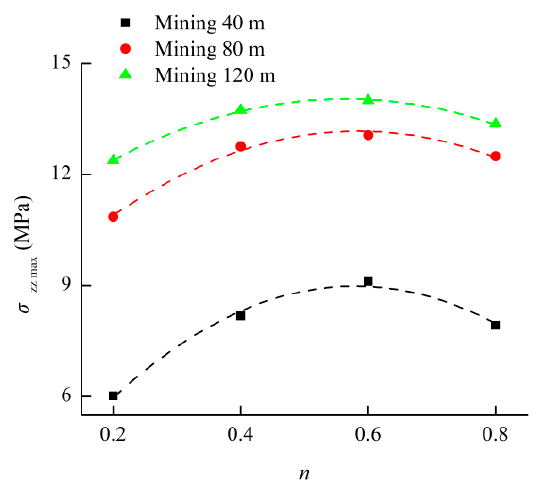
Figure 17. Relationship between the maximum internal stress of the backfill and the Talbot index of the cemented rockfill at different mining distances. Table 9. Relationship between the maximum internal stress of the backfill and Talbot index of the cemented rockfill at different mining distances.